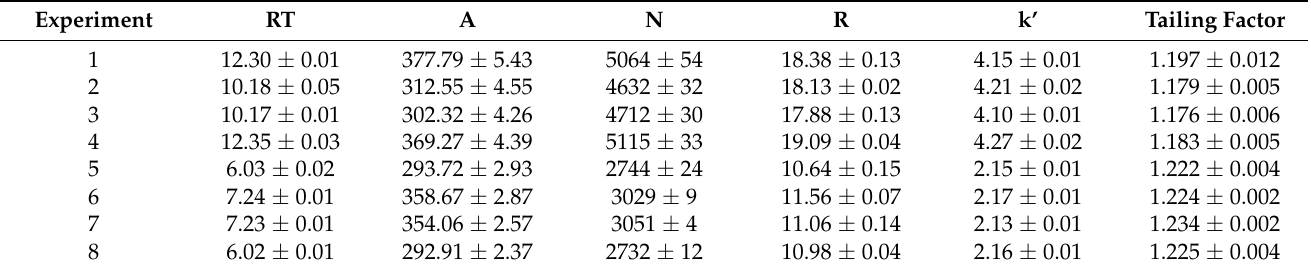
Table 5. Values (average ± standard deviation) of obtained responses for eight experiments of fractional factorial design